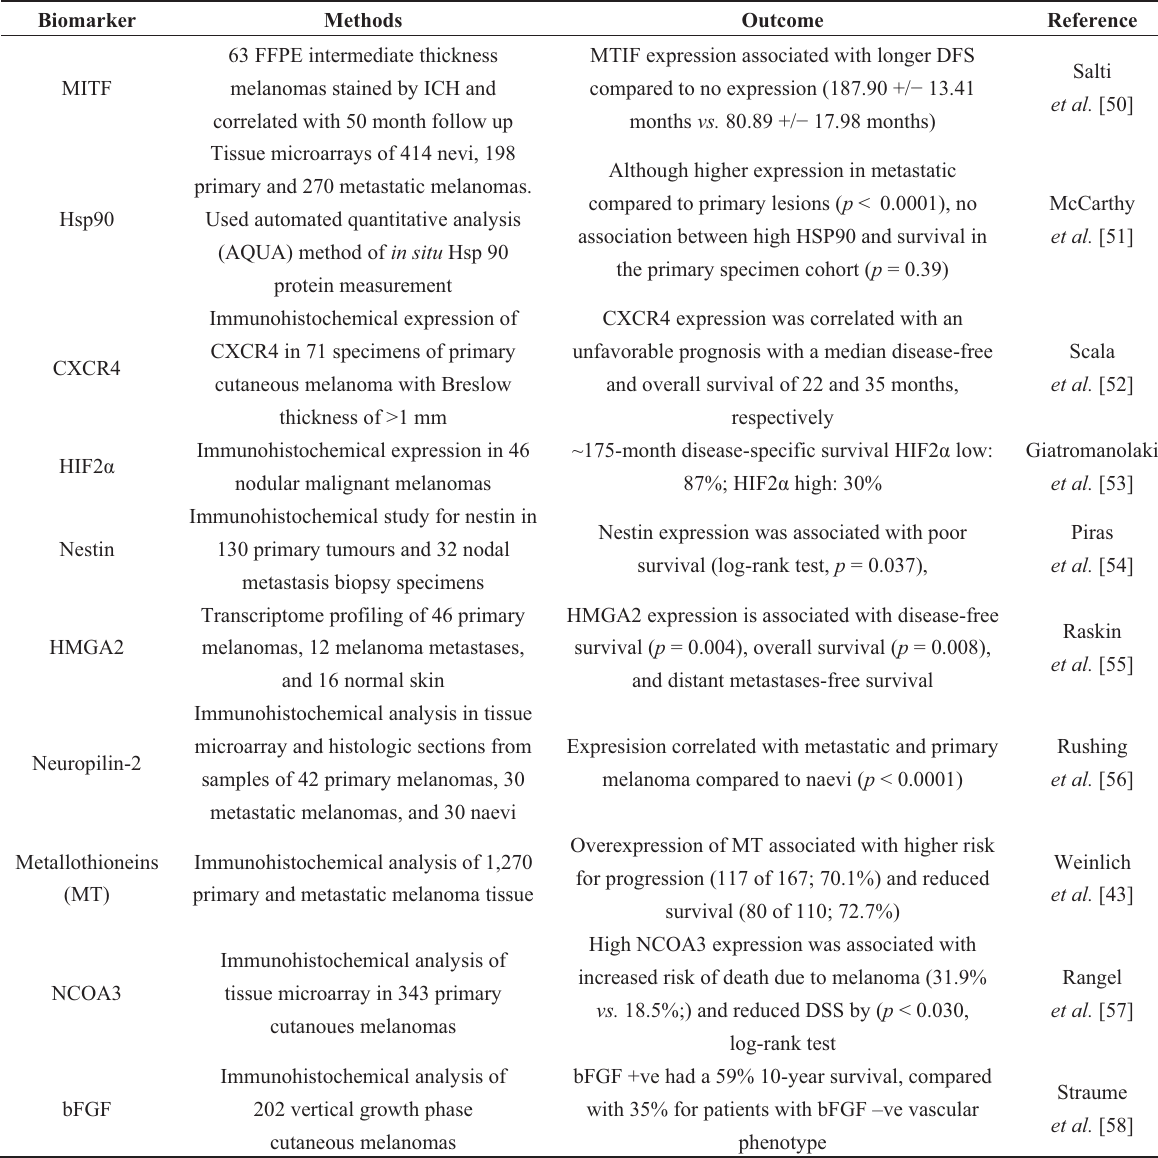
Table 1. Selected historical and novel prognostic